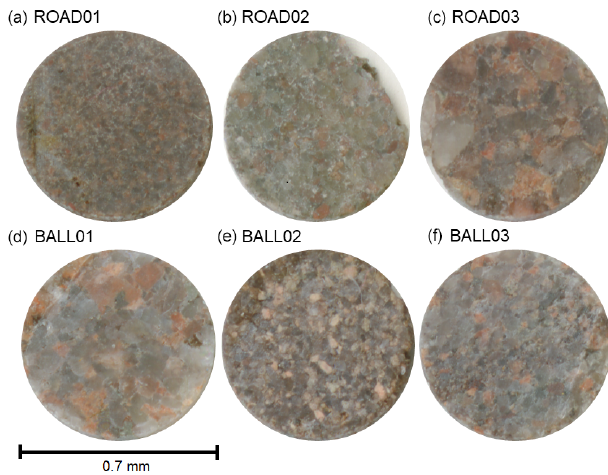
Figure 2. Images of example rock slices (0.7mm diameter) for each sample taken using the EPSON Expression 11000XL flatbed scan-